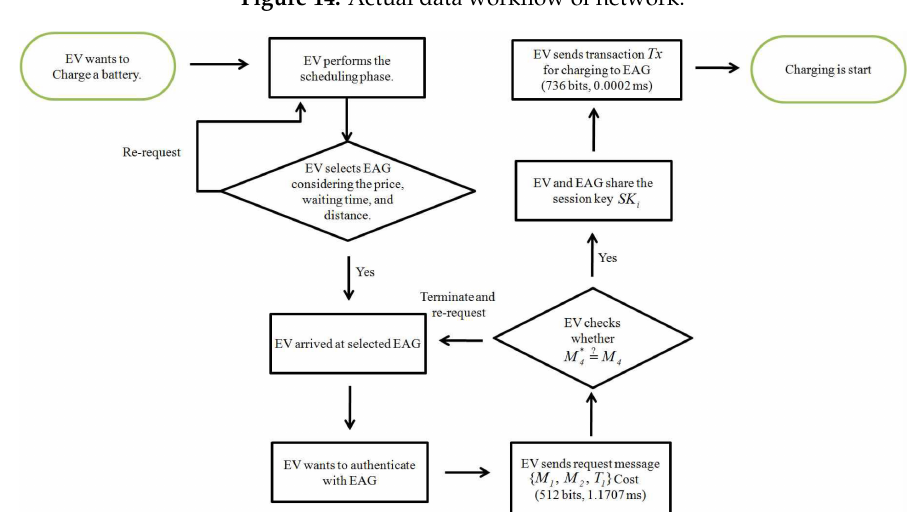
Figure 15. Actual data workflow of